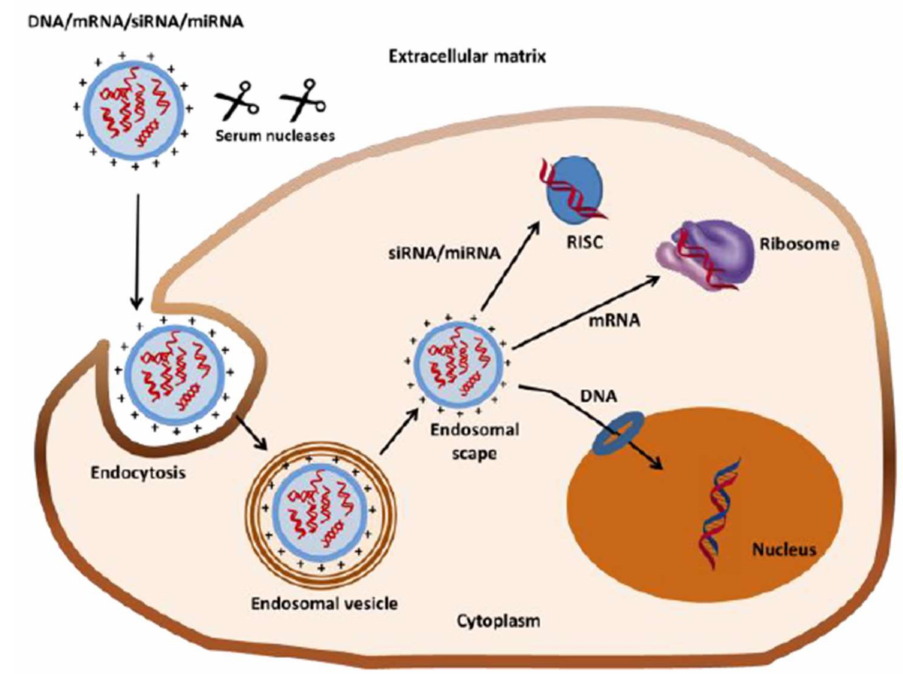
Figure 1. Barriers to successful in vivo delivery of nucleic